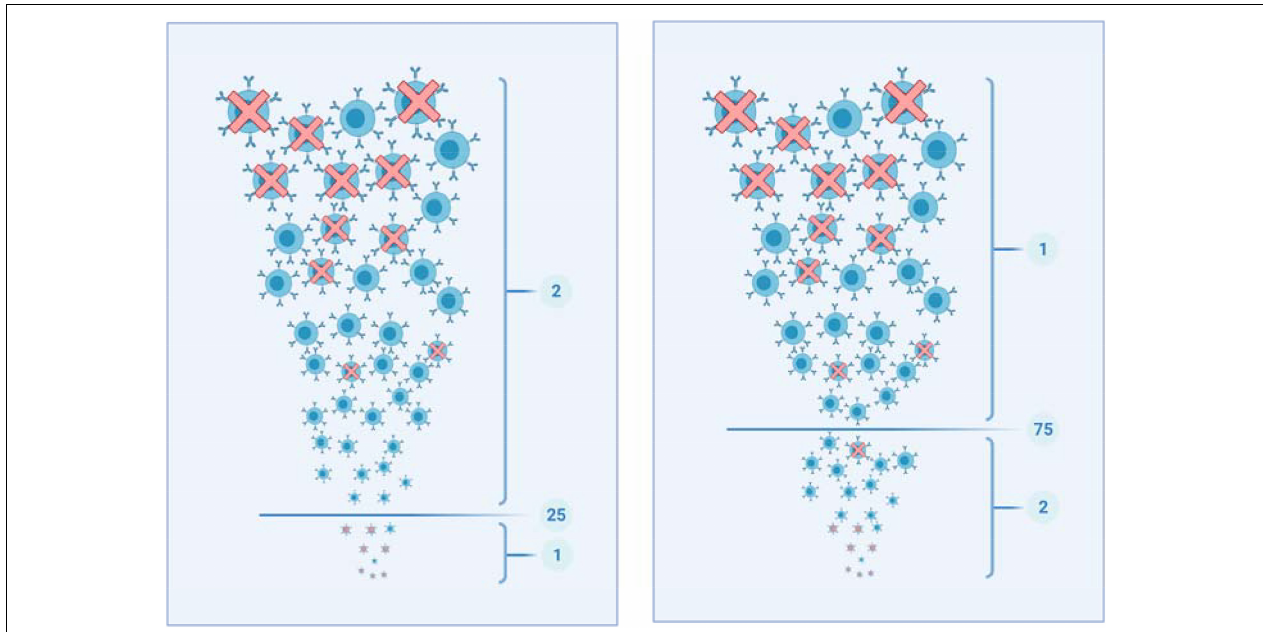
FIGURE 2 | Schematic representation of the procedure used for construction of Table 3 . Each circle represents a methylated CpG site, with its size reflecting the methylation level. Red “X” denotes CpG sites that overlap with known mutable motifs. The left and right panels correspond to thresholds 25% and 75%. The left panel: The set “1” (the methylation levels are smaller than 25%) is compared to set “2” (the methylation levels are larger than 25%). The right panel: The set “1” (the methylation levels are larger than 75%) is compared to set “2” (the methylation levels are smaller than 75%).